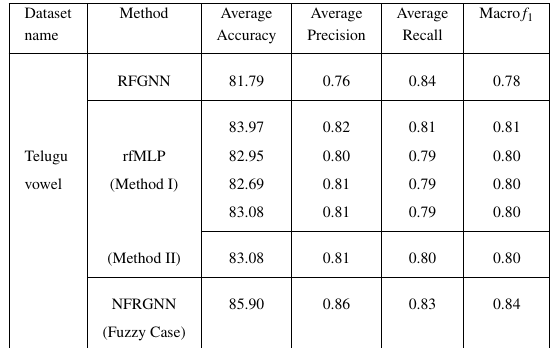
Table 5. Recognition scores for FRGNN, rfMLP and